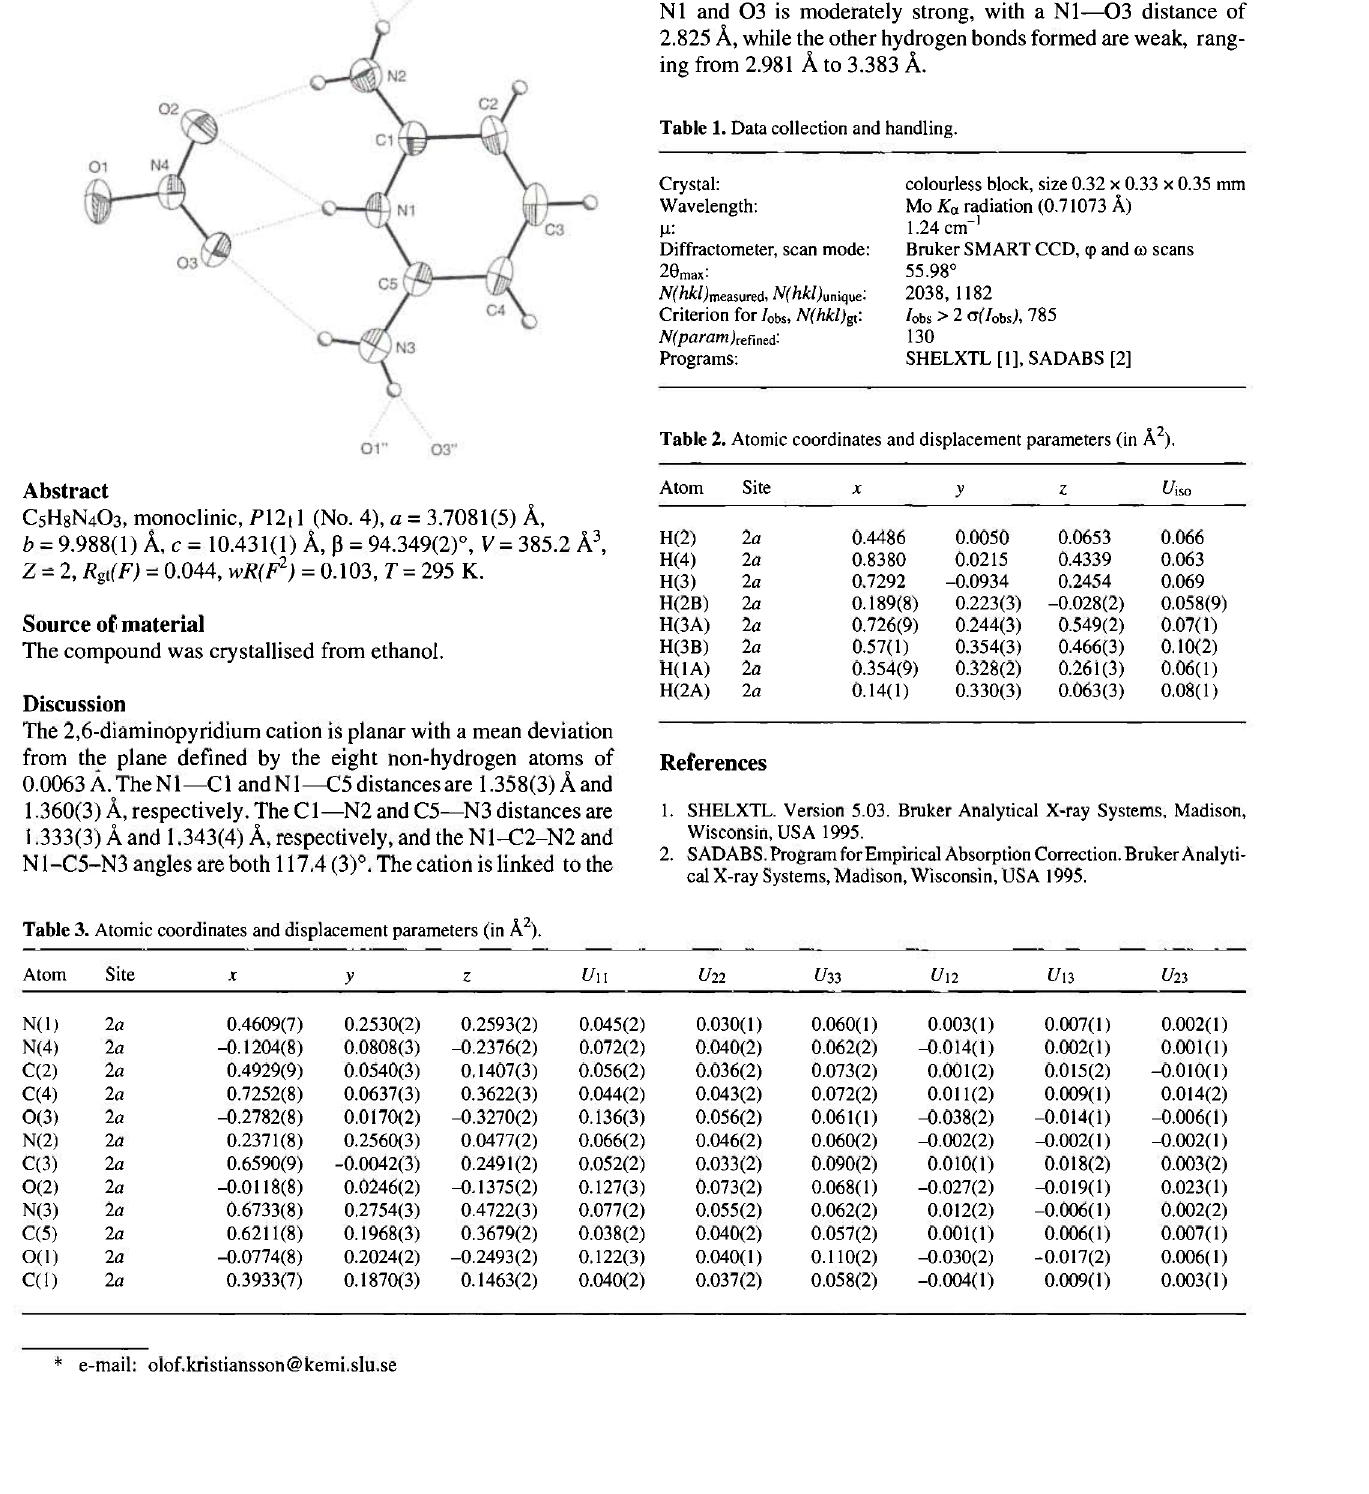
Table 1. Data collection and handling.